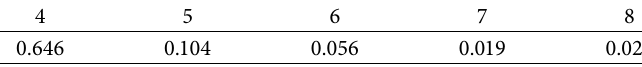
Table 3: Cosine similarities between each IMF and the mixed signal in Figure 4(a).